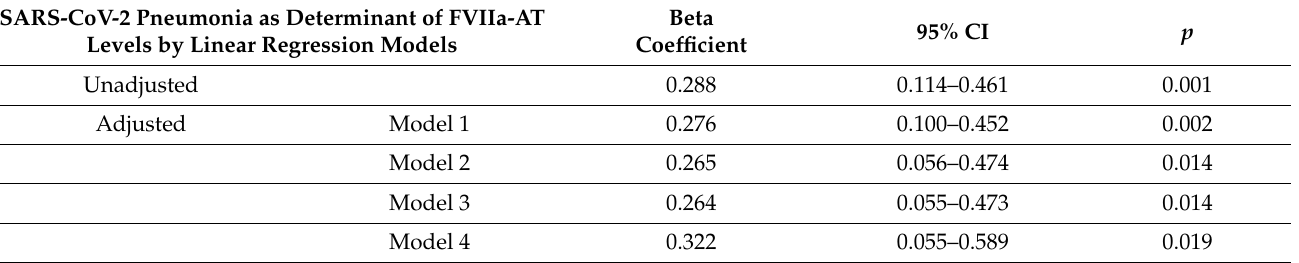
Table 2. SARS-CoV-2 infection as determinant of FVIIa-AT plasma levels. Strength of association between SARS-CoV-2 pneumonia and FVIIa-AT plasma levels in the whole study population by linear regression